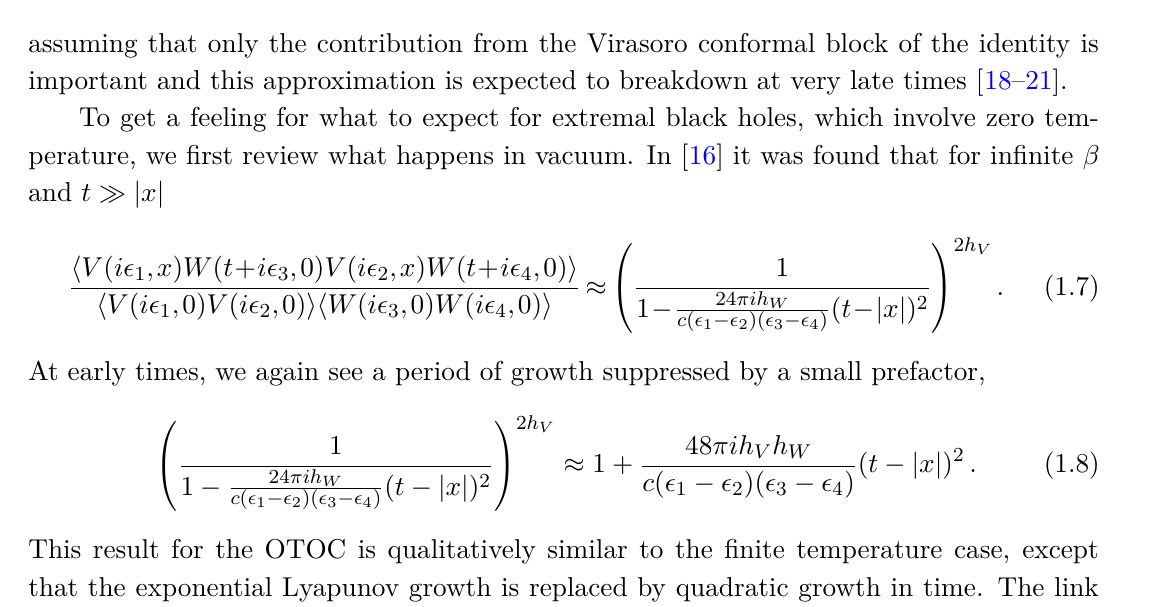
Figure 2. Behaviour of the normalized commutator squared in a 2d holographic CFT. In this plot, h W = exp( − 24 . 5) and h = exp(9) V c(cid:15) ∗ 12 (cid:15) 34